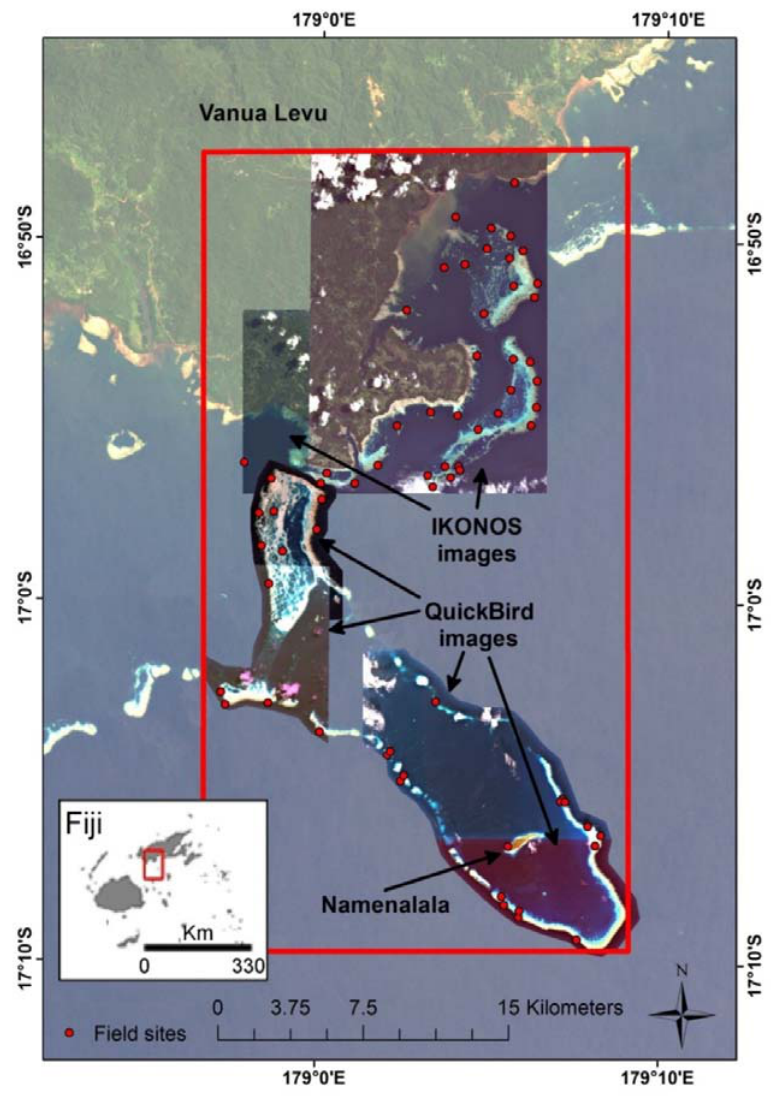
Figure 1. Kubulau District and fisheries management area, Vanua Levu, Fiji. The coverage of high-resolution satellite data inside the red boundary forms the study area, with central coordinates 16°51 ′ S, 179°0 ′ E. Red circles indicate field data collection